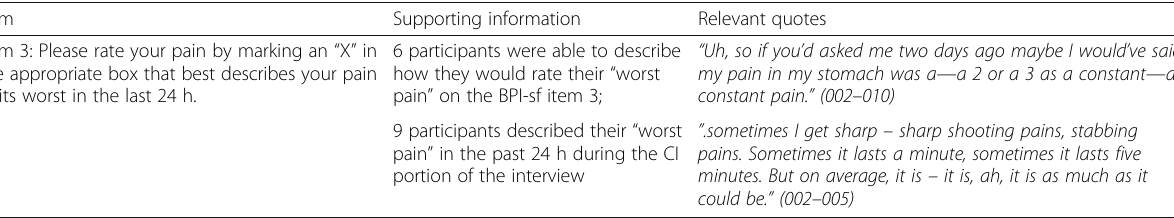
Table 3 Item Mapping of participant quotations to BPI-sf “ Worst Pain ” (Item 3): Pleural participants ( n = 19)